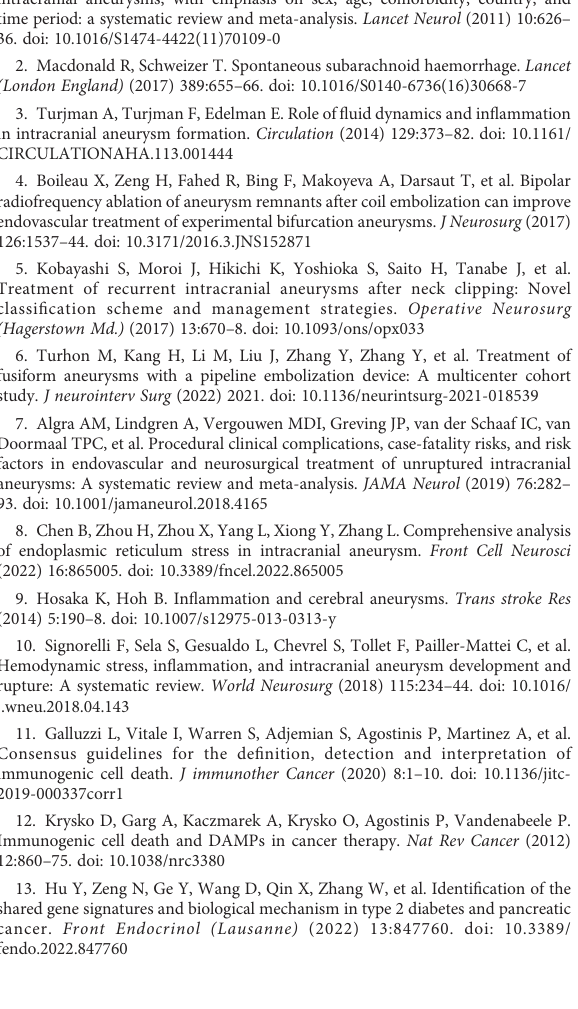
SUPPLEMENTARY FIGURE 4 (A – C) CC, GO-BP, and MF functional enrichment analyses highlight the biological features of the ICD phenotype-linked genes. d. The KEGG enrichment analysis of the ICD phenotype-linked immune genes reveals the correlation between immune regulation and